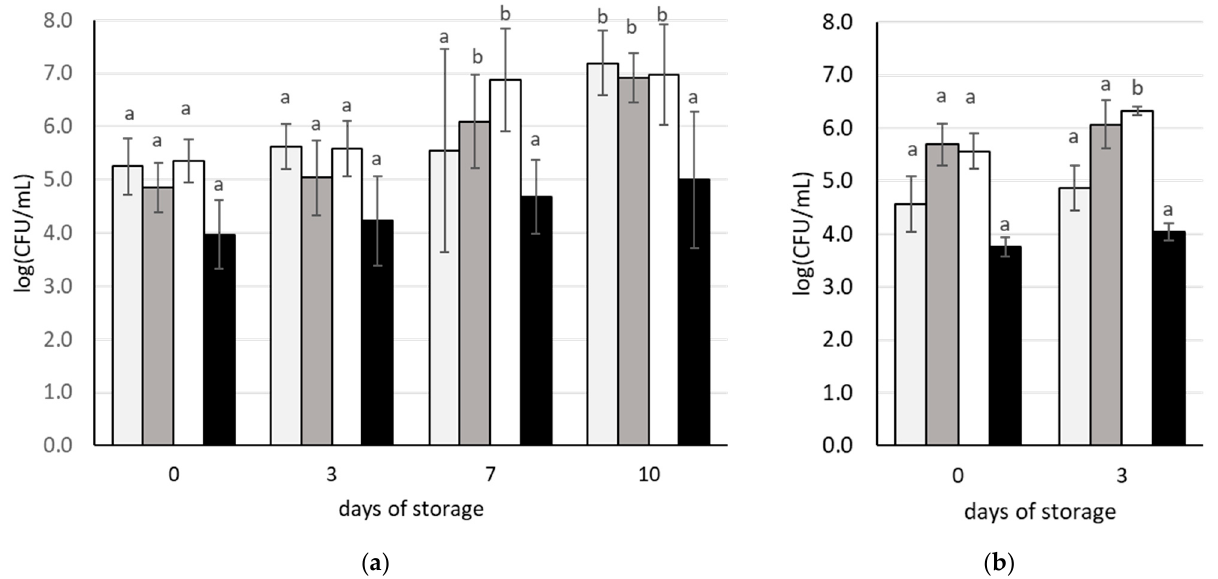
Figure 1. Microbial population during storage for lab-made ( a ) and commercial juice ( b ). Light grey bars: psychrotrophic bacteria, grey bars: yeasts and molds, white bars: enterobacteria, black bars: lactic acid bacteria. Bars represent means of values for batches L1 to L7 for lab-made juices, with the number of batches being 7, 7, 6, and 4 at days 0, 3, 7, and 10 days respectively, and for batches C1 to C3 for company juices. Error bars correspond to standard deviations and different letters indicate significant differences between days of storage for a group of microorganisms and a type of juice (lab-made or